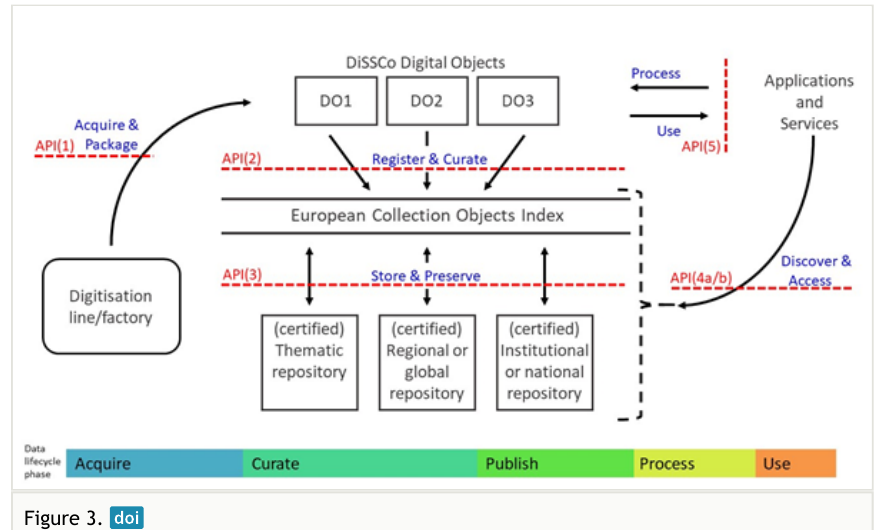
Figure 3. From Hub platform to APIs, data lifecycle and system design.